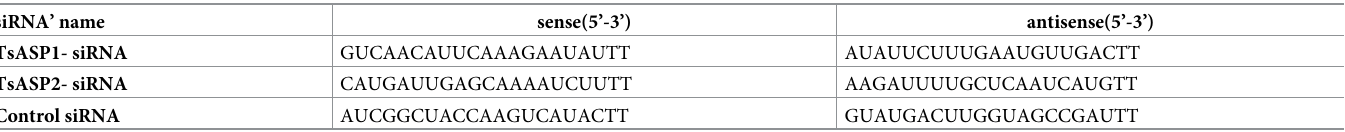
Table 1. The sequences of the